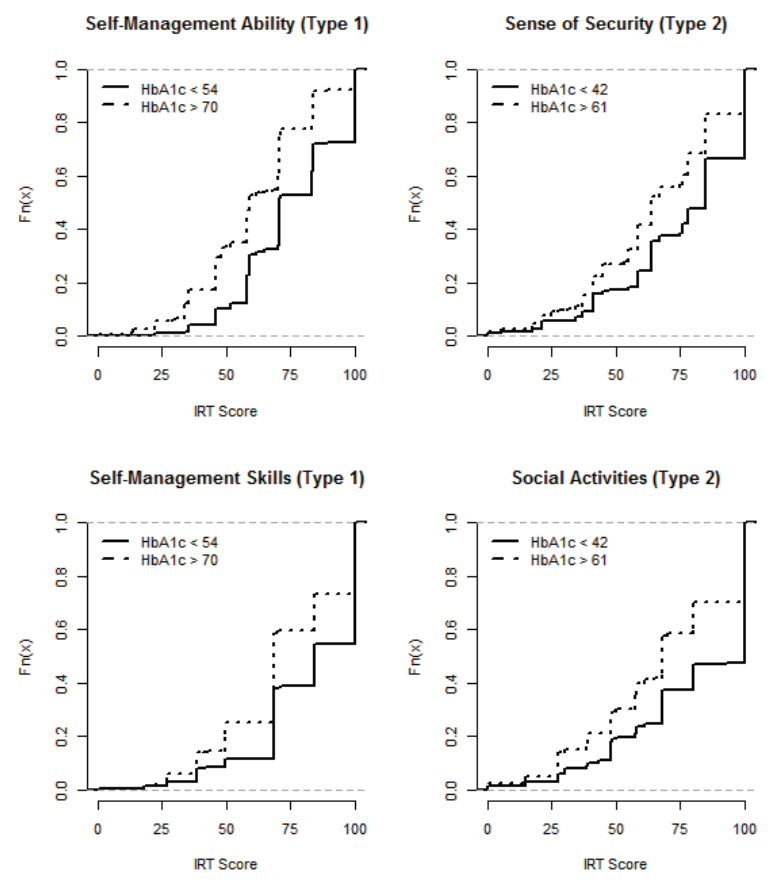
Figure 4. Empirical distribution functions: Self-Management Ability and Skills in type 1 diabetes, and Sense of Security and Social Activities in type 2 diabetes, by HbA